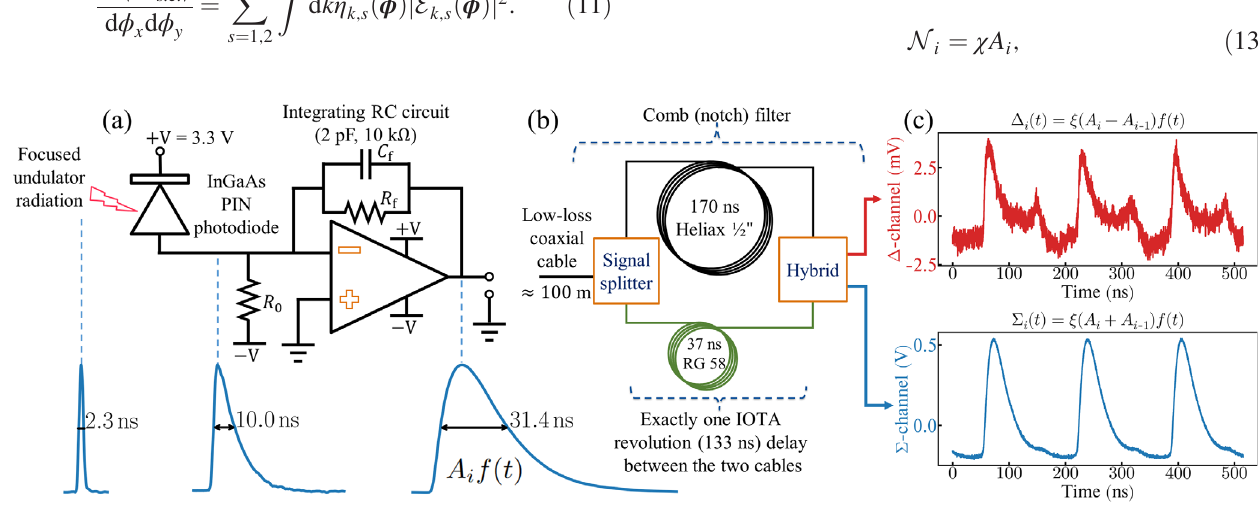
FIG. 4. (a) Photocurrent integrator circuit. (b) Comb filter. (c) Sample waveforms of hybrid outputs ( Δ - and Σ